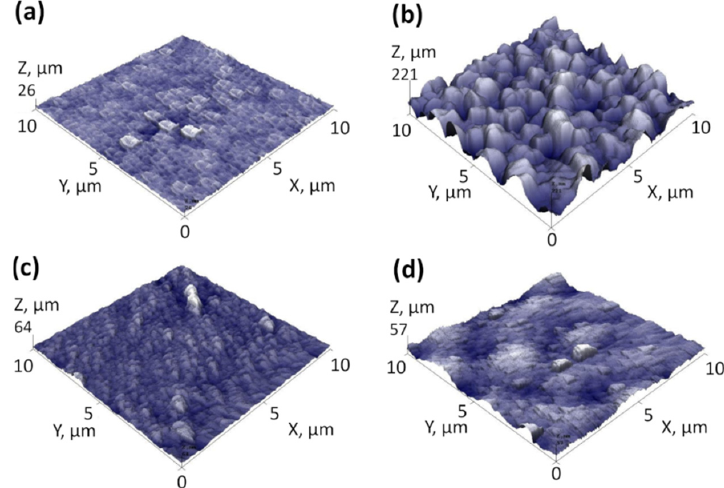
Figure 3. AFM surface measurements of C-doped TiO 2 films deposited on various underlayers: ( a ) C-doped TiO 2 film without underlayer; ( b ) Cu underlayer; ( c ) Nb underlayer; ( d ) Ni underlayer.